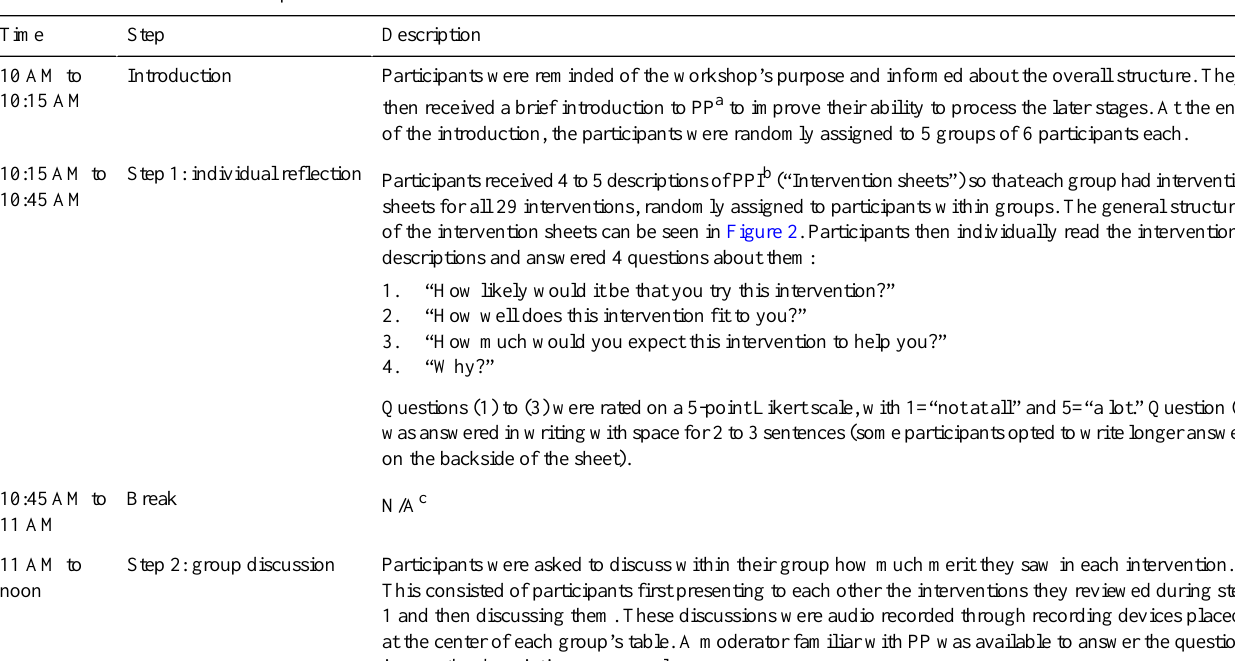
Table 1. Timeline of the workshop.